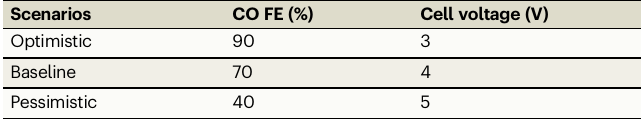
Table 1 | Summary of CO Faradaic ef fi ciency and cell voltages for the integrated electrolyser in different scenarios Scenarios